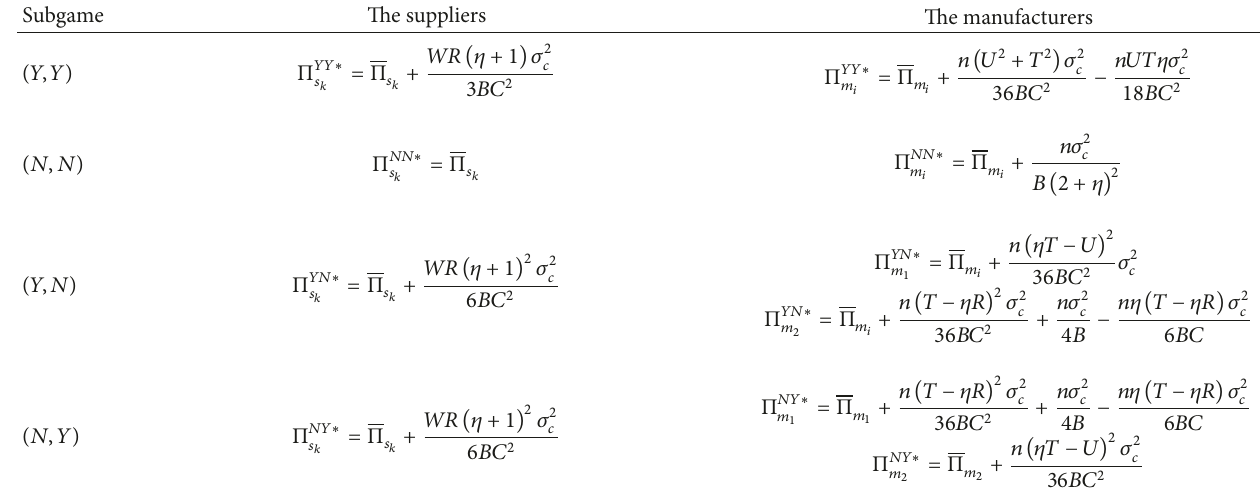
Table 1: The manufacturers’ and suppliers’ ex ante payoffs.